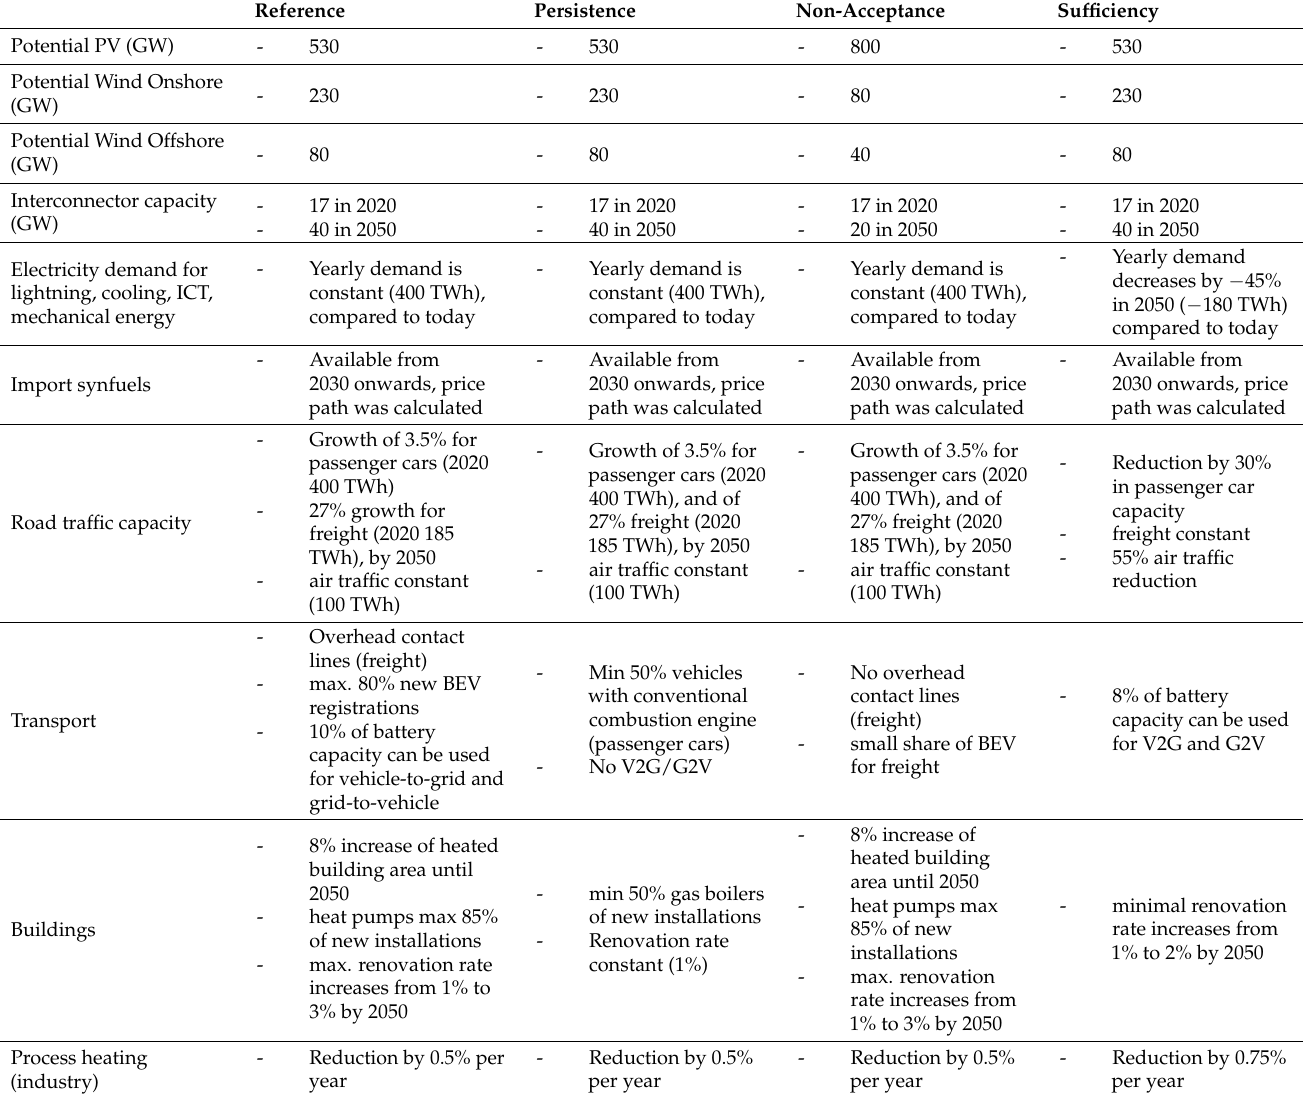
Table 1. Scenario assumptions. Unless otherwise stated, this means that the assumptions of the reference scenario